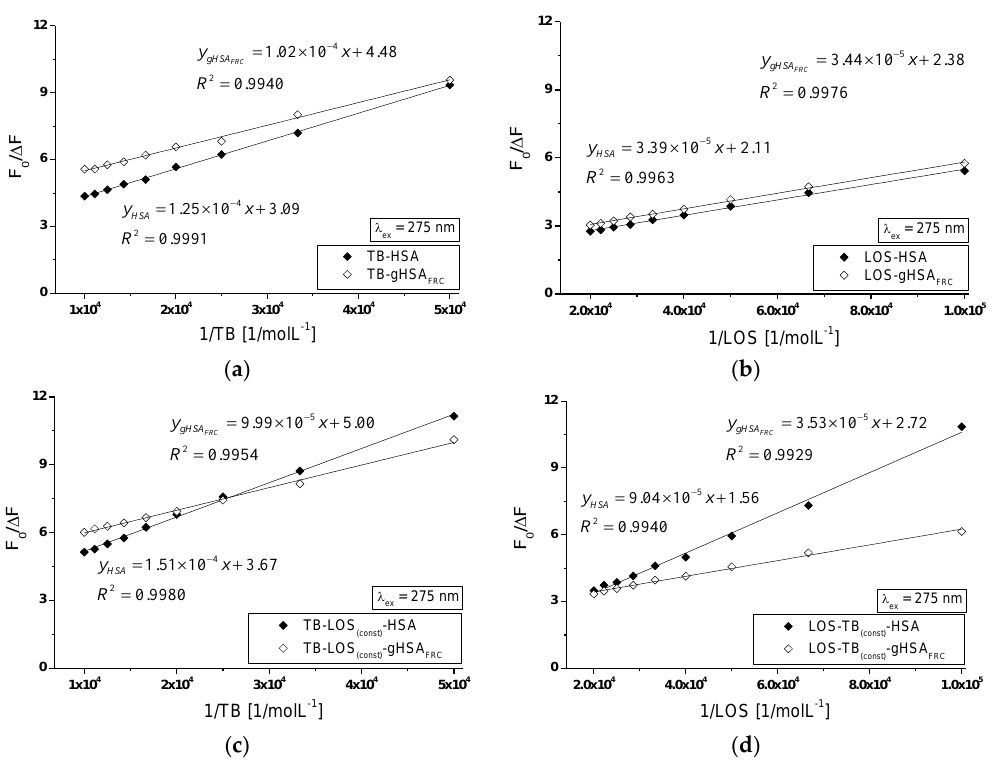
Figure 14. The Stern-Volmer curves modified by Lehrer for the binary ( a ) TB-HSA, TB-gHSA FRC ; ( b ) LOS-HSA, LOS-gHSA FRC and ternary systems ( c ) TB-LOS (const) -HSA, TB-LOS (const) -gHSA FRC , ( d ) LOS-TB (const) -HSA, LOS-TB (const) -gHSA FRC , λ ex = 275 nm; the error bars are smaller than the symbols. Table 3. Stern-Volmer constants 𝐾 𝑆𝑉 (mol −1 ∙L), fractional accessible protein fluorescence 𝑓 𝑎 and biomolecular quenching rate constant 𝑘 𝑞 (mol −1 ∙L∙s −1 ) calculated for the binary system: TB-HSA, TB- gHSA FRC , LOS-HSA, LOS-gHSA FRC ; λ ex = 275 nm and λ ex = 295 nm.